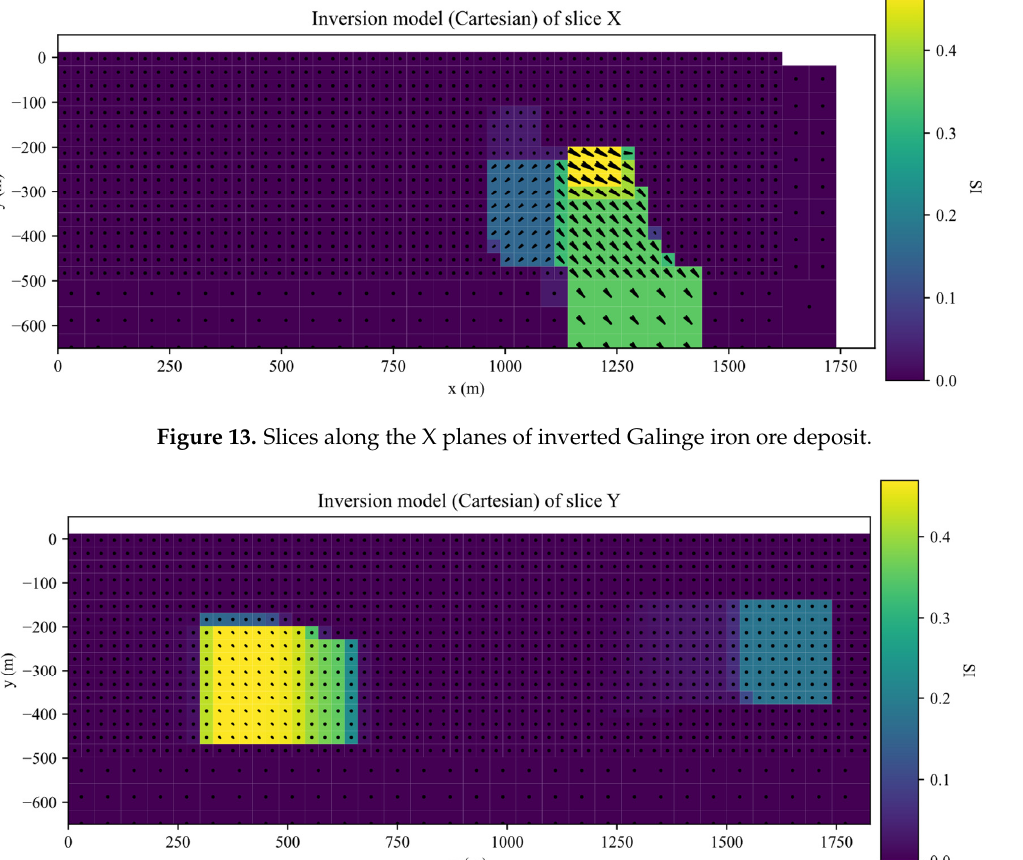
Figure 15. Slices along the Z planes of inverted Galinge iron ore deposit.